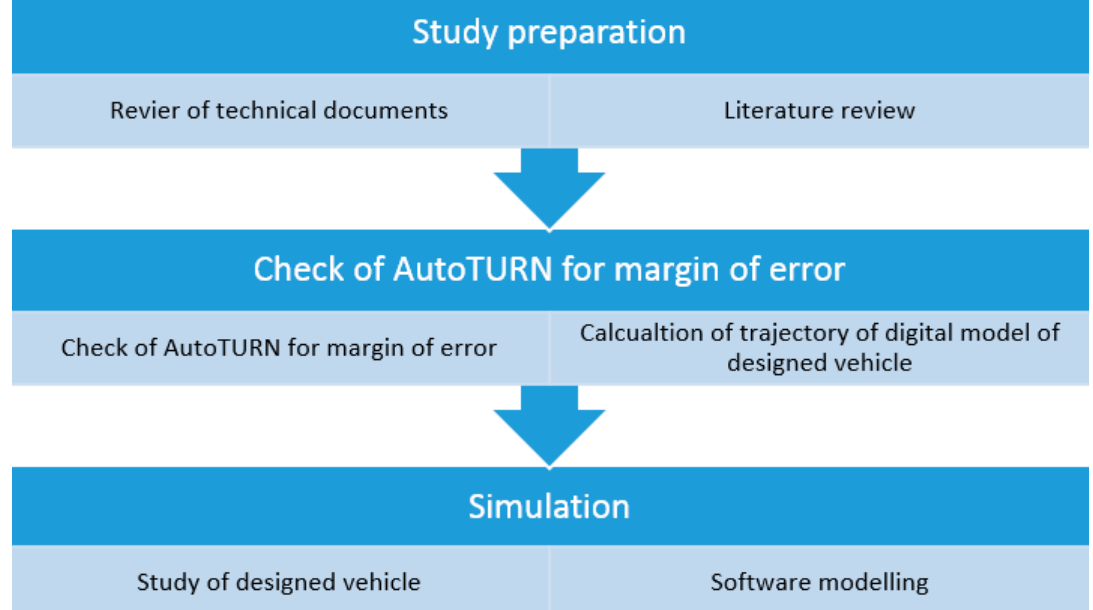
Figure 4. The structure of the conducted research.